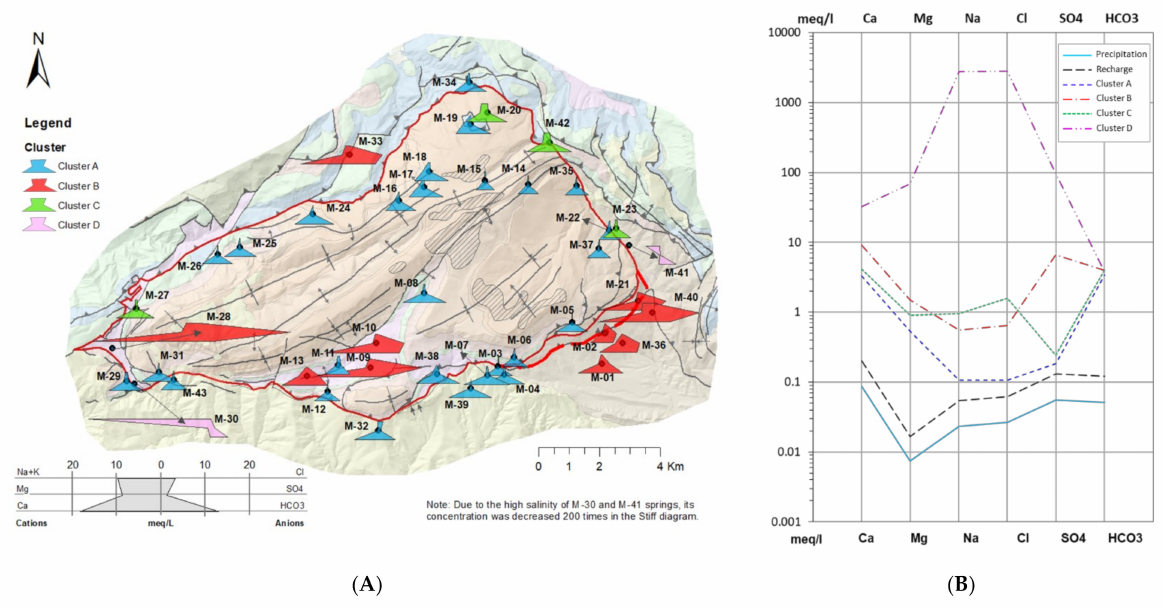
Figure 2. ( A ) Map of springs with the associated modified Stiff diagrams colored according to their corresponding cluster. For each spring, the different ionic content values (in meq/L) are obtained averaging the corresponding values for all the GW sampling campaigns during the period September 2013–October 2015.; ( B ) Schoeller—Berkaloff diagram. Hydrochemical data corresponds to precipitation [62] calculated recharge with a concentration factor and GW as an average composition for the different